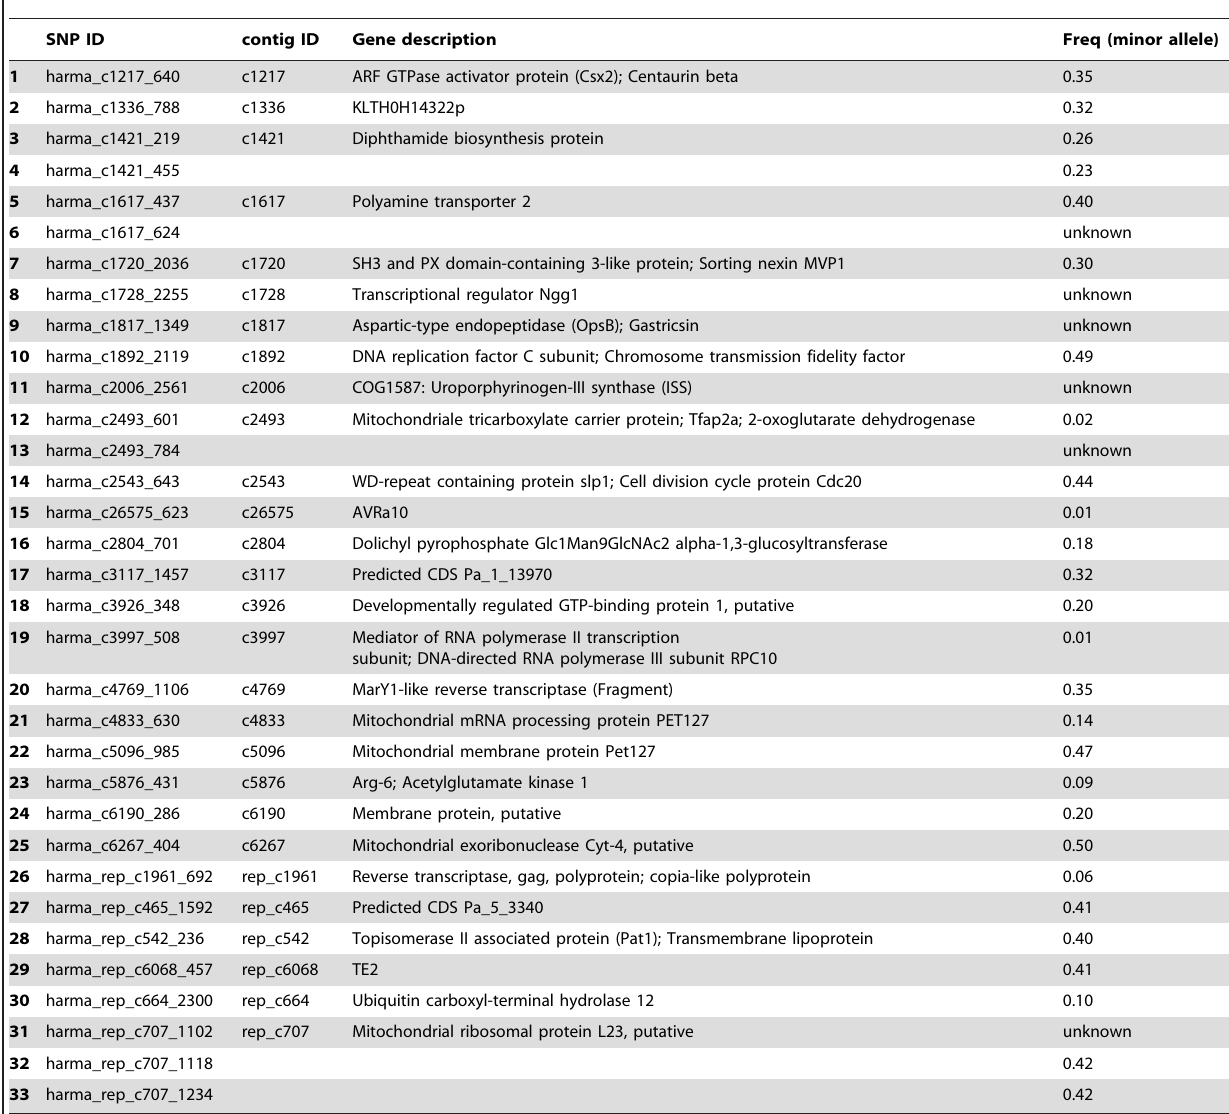
Table 1. Characteristics of the 33 SNP loci discovered in Po. plantaginis populations from the A˚land archipelago: contig number, functional description of the gene (inferred from PANZER) and minor allele frequency in the dataset genotyped (the latter being available only for the 27 loci included in the SNP genotyping